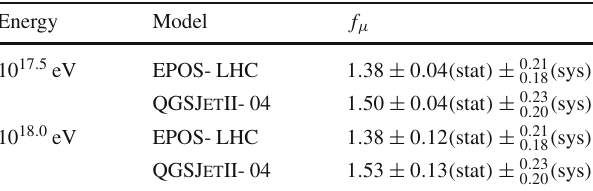
Table 2 Ratio f μ = exp ( (cid:14) ln ρ 35 (cid:15) UMD − (cid:14) ln ρ 35 (cid:15) sim ) of the muon con- tent in data and simulations with statistical and systematic uncertainties at primary energies of 10 17 . 5 eV and 10 18 eV for the EPOS- LHC